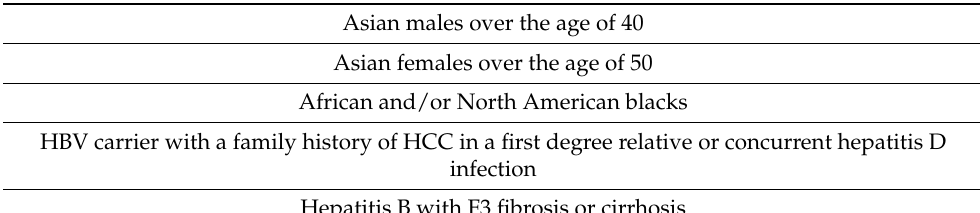
Table 1. Indications for surveillance in hepatitis B virus (HBV) patients per the American Association of the Study of Liver Disease (AASLD) guidelines